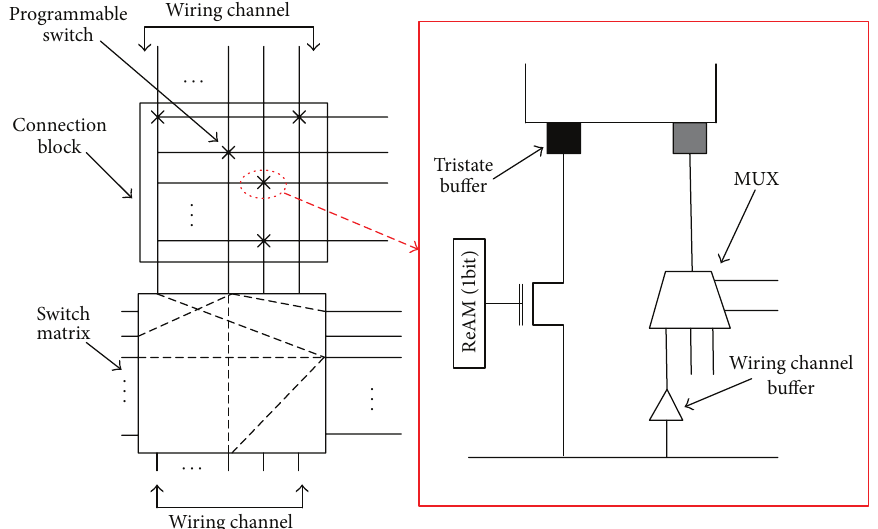
Figure 5: A generic FPGA consisted of CLB, IOB, and IR. The SRAM cells of FPGA switch matrix are replaced with ReRAM cells.